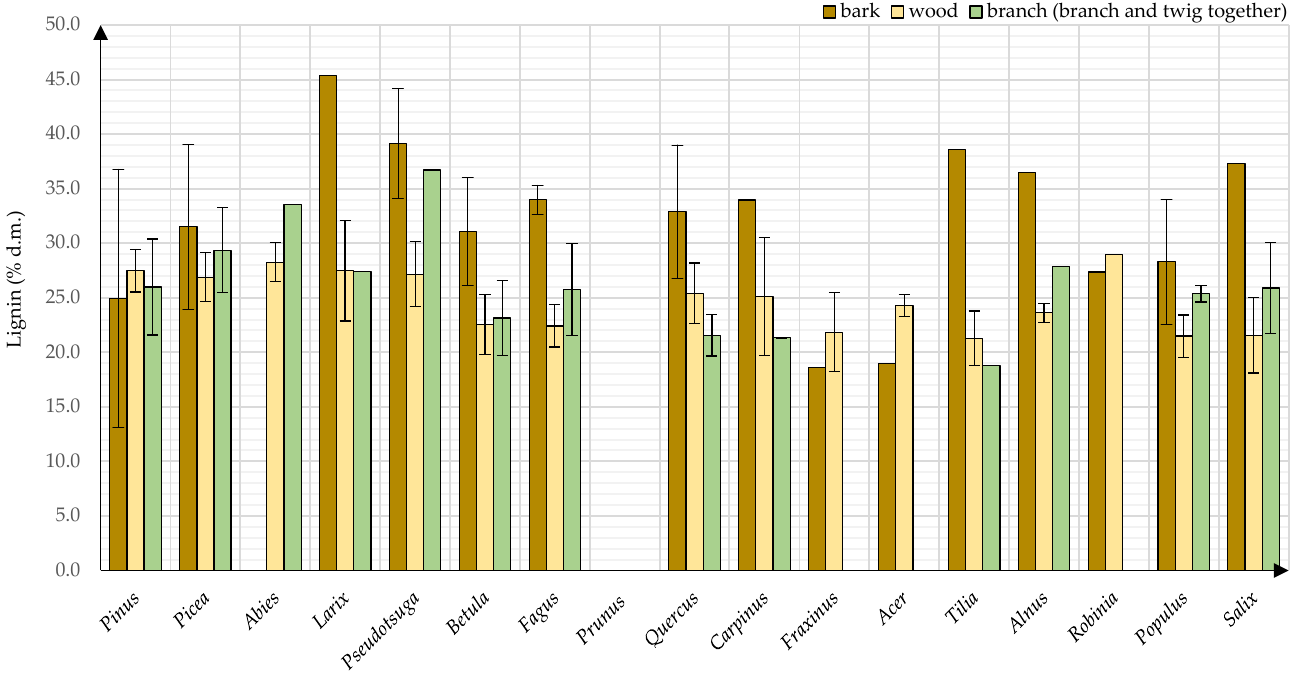
Figure 16. Average value and average deviation of the lignin content of organs of particular systematic genera trees.